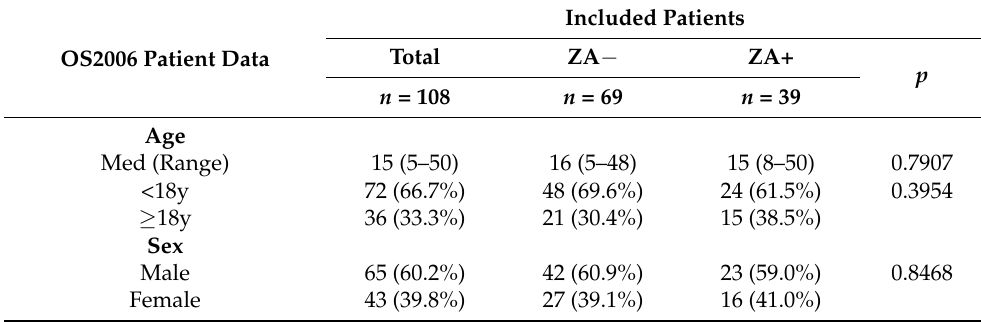
Table 1. Demographic, clinical and histological data of the OS2006 patient cohort included in the present study ( n =